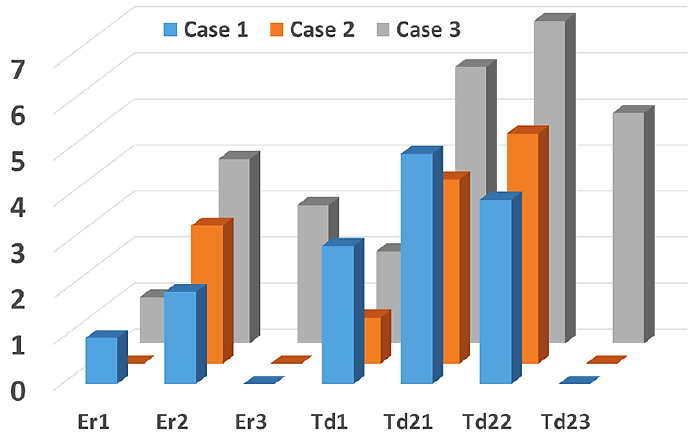
Figure 5. Comparison of confidence level in the estimated model parameters.